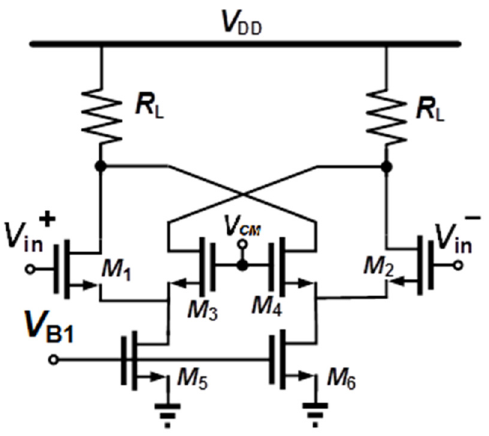
Figure 7. Schematic of the buffer.